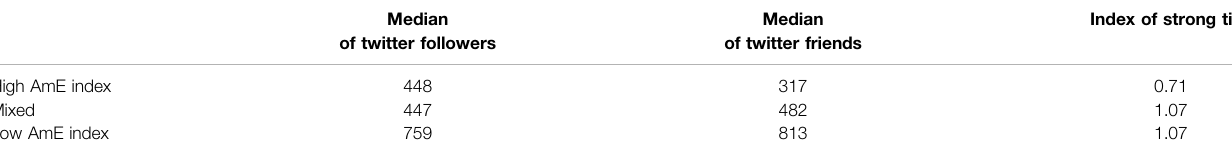
TABLE 4 | Network sizes and users ’ AmE